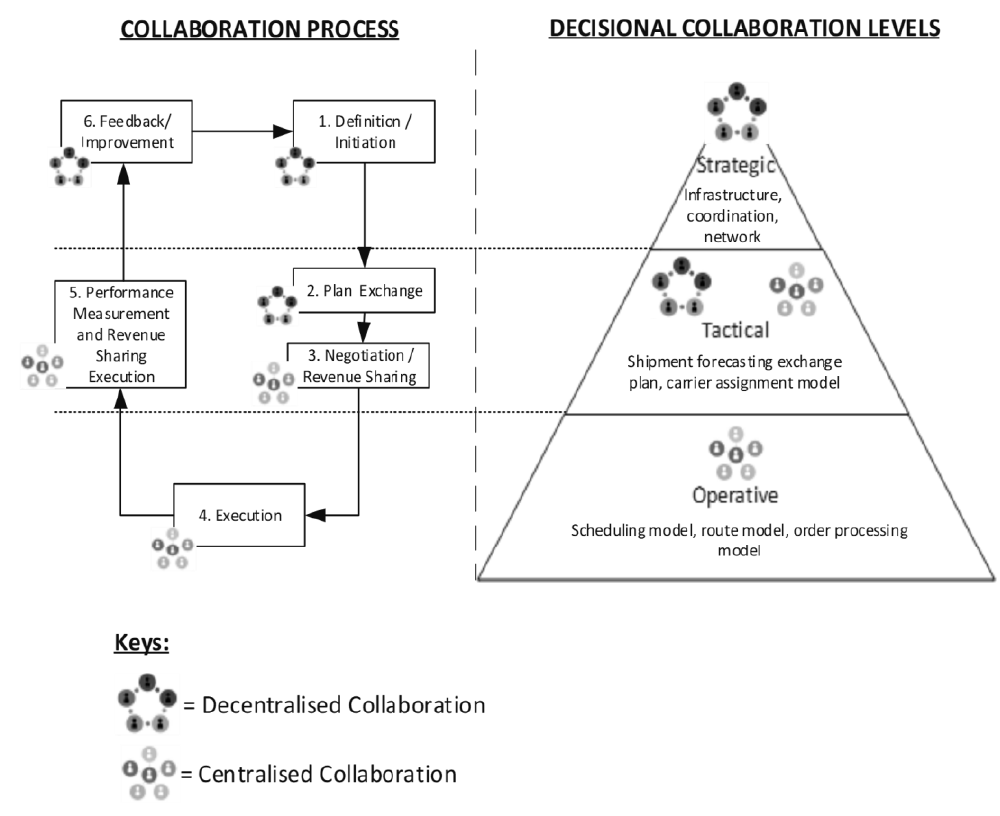
Figure 6. Proposed collaboration process implementation using a combine coordination structure and relationship with decisional collaboration levels.